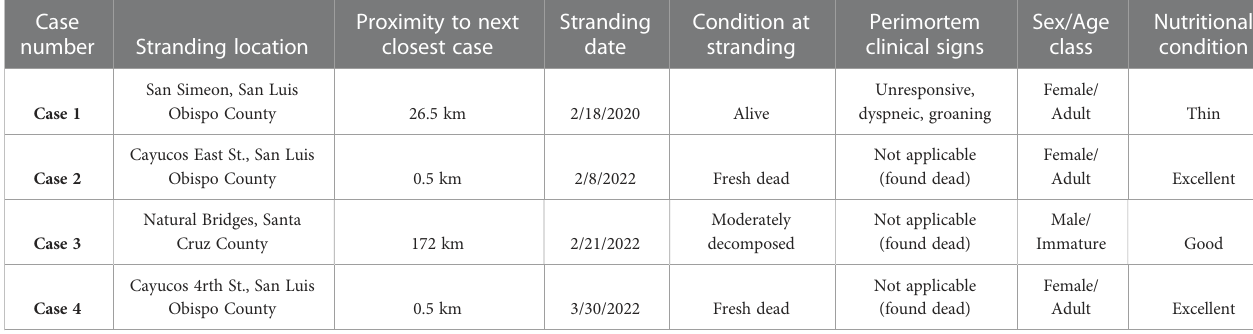
TABLE 1 Demographical and geographical data for southern sea otters ( Enhydra lutris nereis ) with fatal Toxoplasma gondii -associated steatitis and